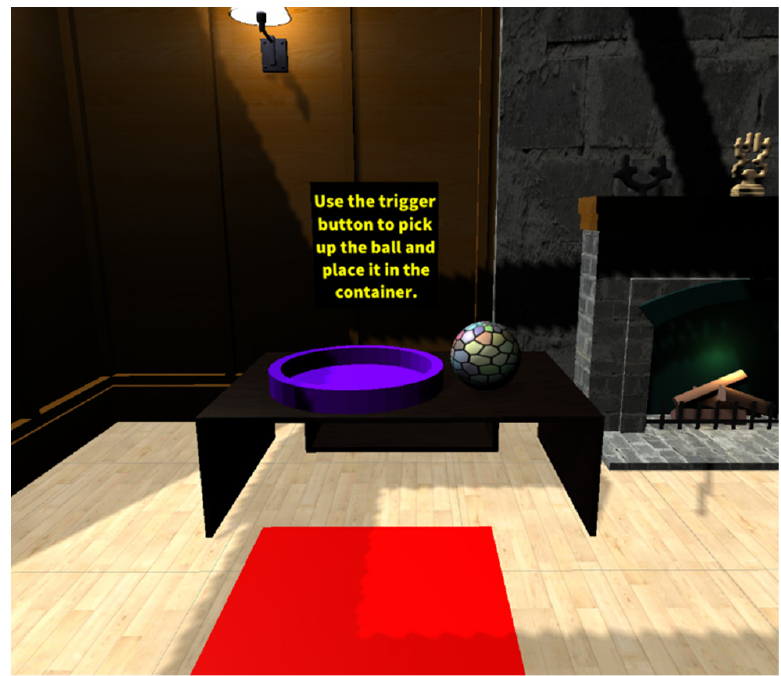
Figure 1. Image of a station with a ball and bucket including verbal prompt.